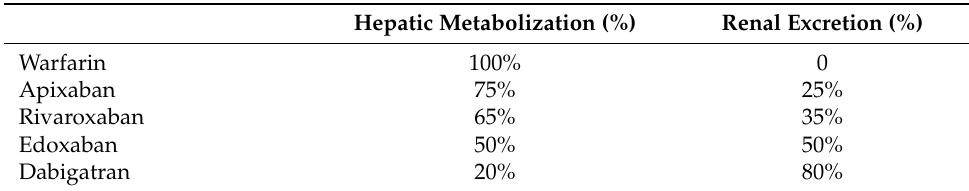
Table 2. Oral anticoagulants and their metabolism pathways. Hepatic Metabolization (%) Renal Excretion (%) Warfarin 100% 0 Apixaban 75% 25% Rivaroxaban 65% 35% Edoxaban 50%